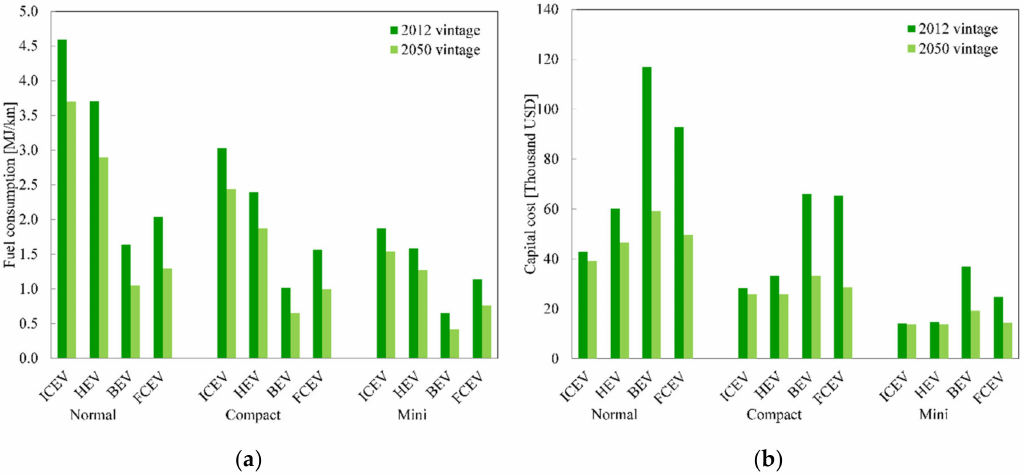
Figure 2. Main characteristics of the road freight vehicles: ( a ) fuel consumption; ( b ) capital cost.